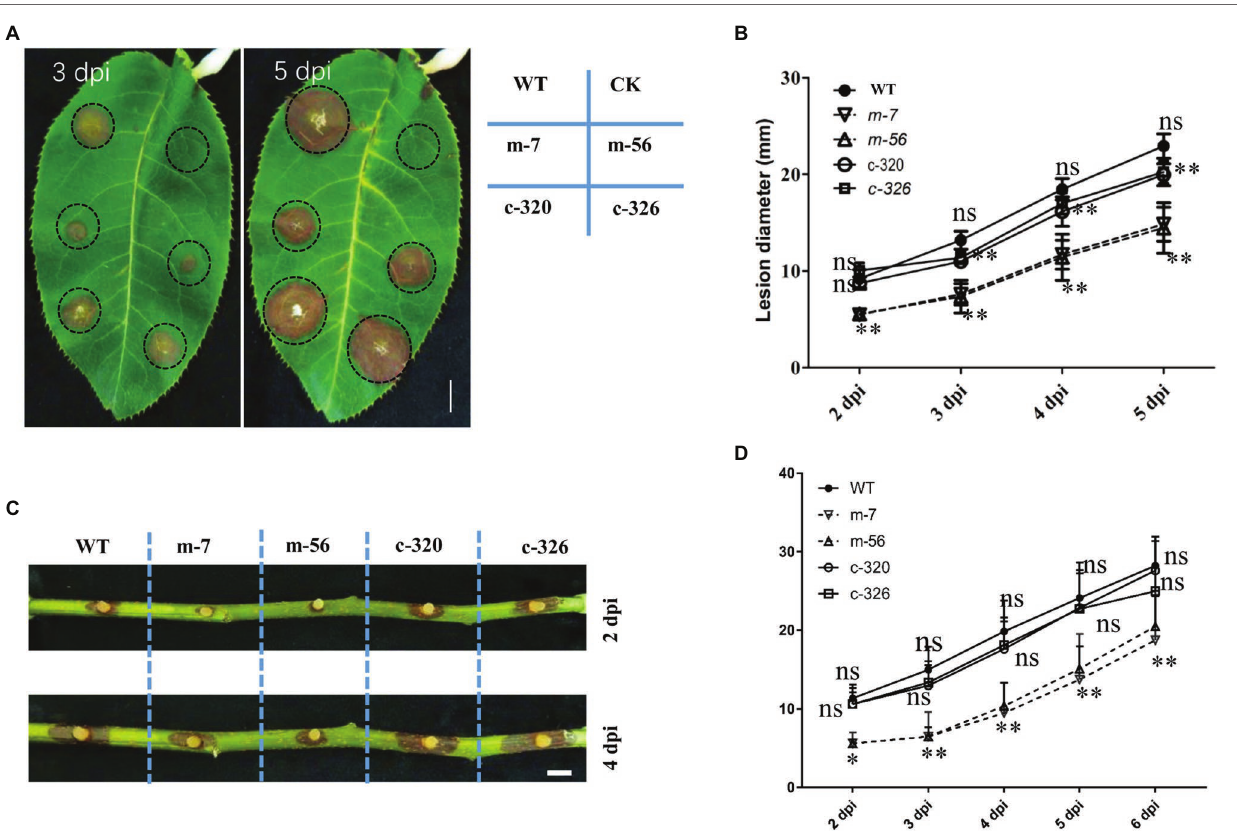
FIGURE 3 | Effect of VpxlnR on virulence. (A) Virulence of the vpxlnR mutants on pear leaves. Mycelial agar plugs of the strains, including WT, vpxlnR mutants, and complementation, were inoculated on pear leaves. Photos were taken at 3 and 5 dpi, respectively. Lesion diameters were measured at 2–5 dpi. (B) Lesion diameters on pear leaves. Lesion diameters were collected on eight leaves. (C) Pathogenicity of the vpxlnR mutants on pear branches. Related strains were inoculated on wounded 1-year-old branches, and branches were incubated at 25 ° C in the dark. Branch images were captured at 2 and 4 dpi. Lesion diameters were measured at 2–6 dpi. (D) Lesion lengths on pear branches. Lesion lengths were obtained from 13 inoculated branches. Bar = 1 cm, ns indicates a value of p > 0.05, * indicates a value of p < 0.05, and ** indicates a value of p < 0.01; the statistical analysis was performed by two-way